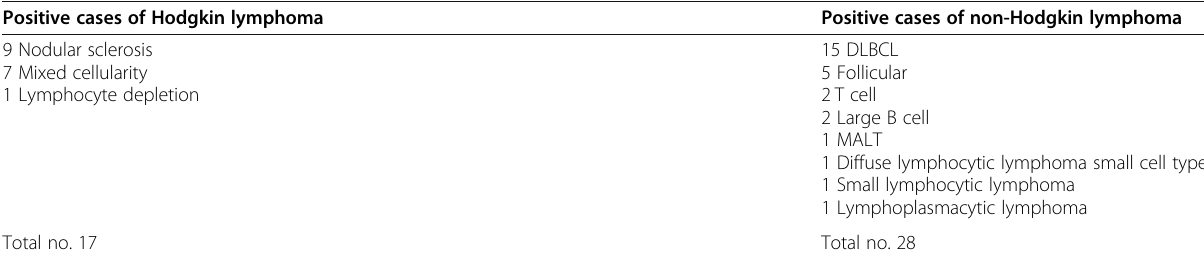
Table 4 Lymphoma cases with BMI Positive cases of Hodgkin lymphoma Positive cases of non-Hodgkin